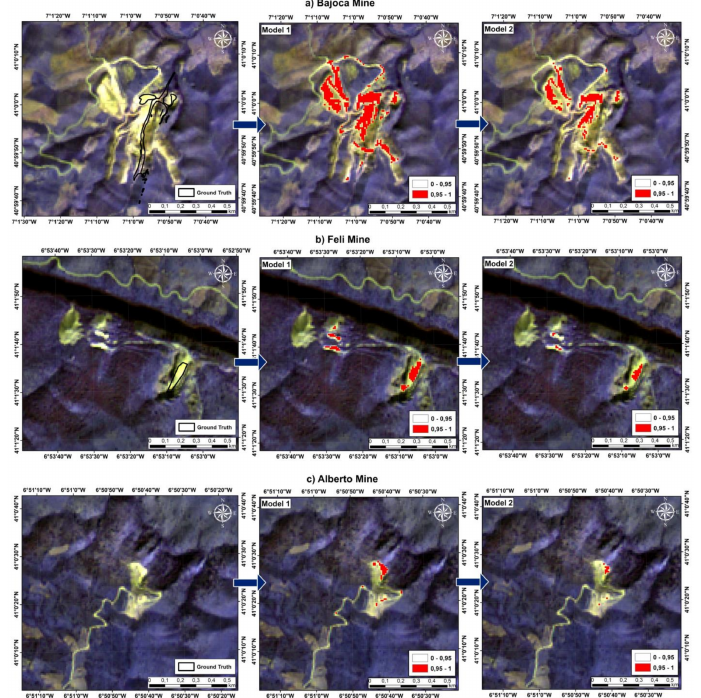
Figure 9. Reduction/elimination of misclassified pixels of Li distribution probabilities when com- paring Remote Sensing Model 1 and 2 for the three training areas: ( a ) Bajoca Mine, ( b ) Feli Mine, ( c ) Alberto Mine.